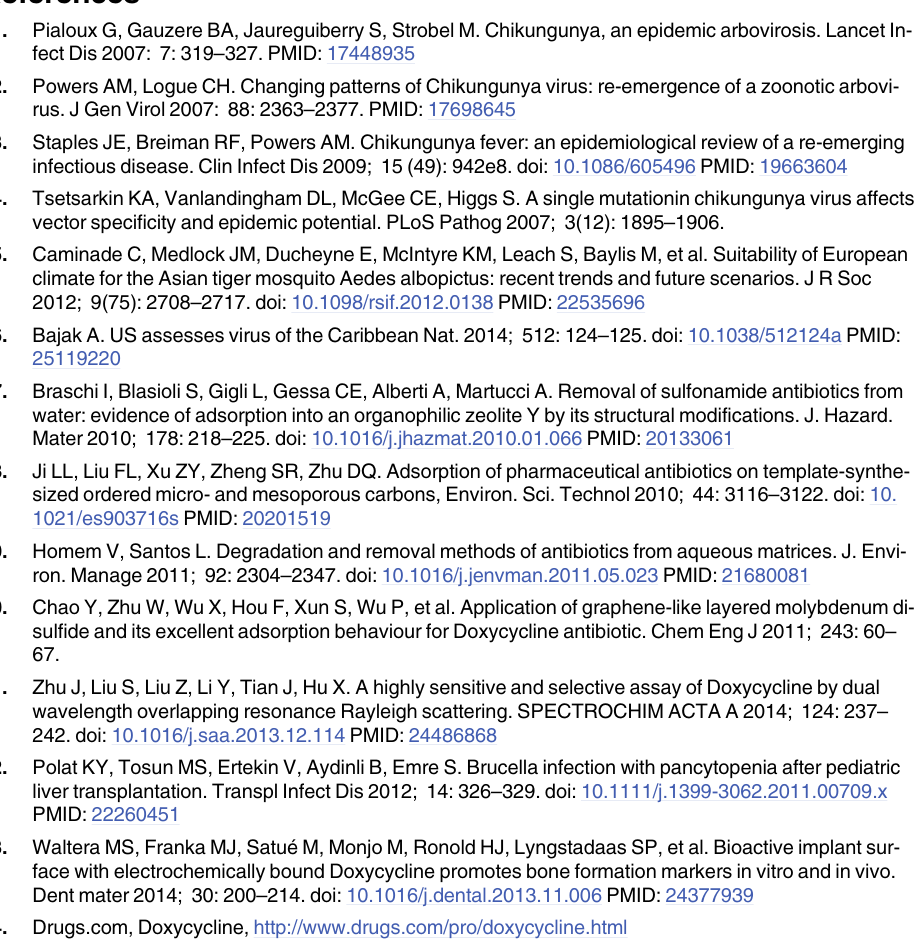
S3 Fig. Changes in the liver and spleen weight of CHIKV-infected mice after the treatment with RIBA and DOXY. (A) Mice were infected with CHIKV and treated with RIBA alone or in combination with DOXY. After 7 days post-infection, CHIKV-infected mice showed liver and spleen hypertrophy (B) Liver of CHIKV-infected mice was larger and irregular compared to normal. DOXY+RIBA showed considerable enhancement in liver size and shape but not RIBA or DOXY alone. (C) Spleen of CHIKV-infected mice increased in size compared to nor- mal. DOXY+RIBA treatment successfully reduced the size of spleen while treatment with ei- ther RIBA or DOXY individually showed insignificant effect on spleen